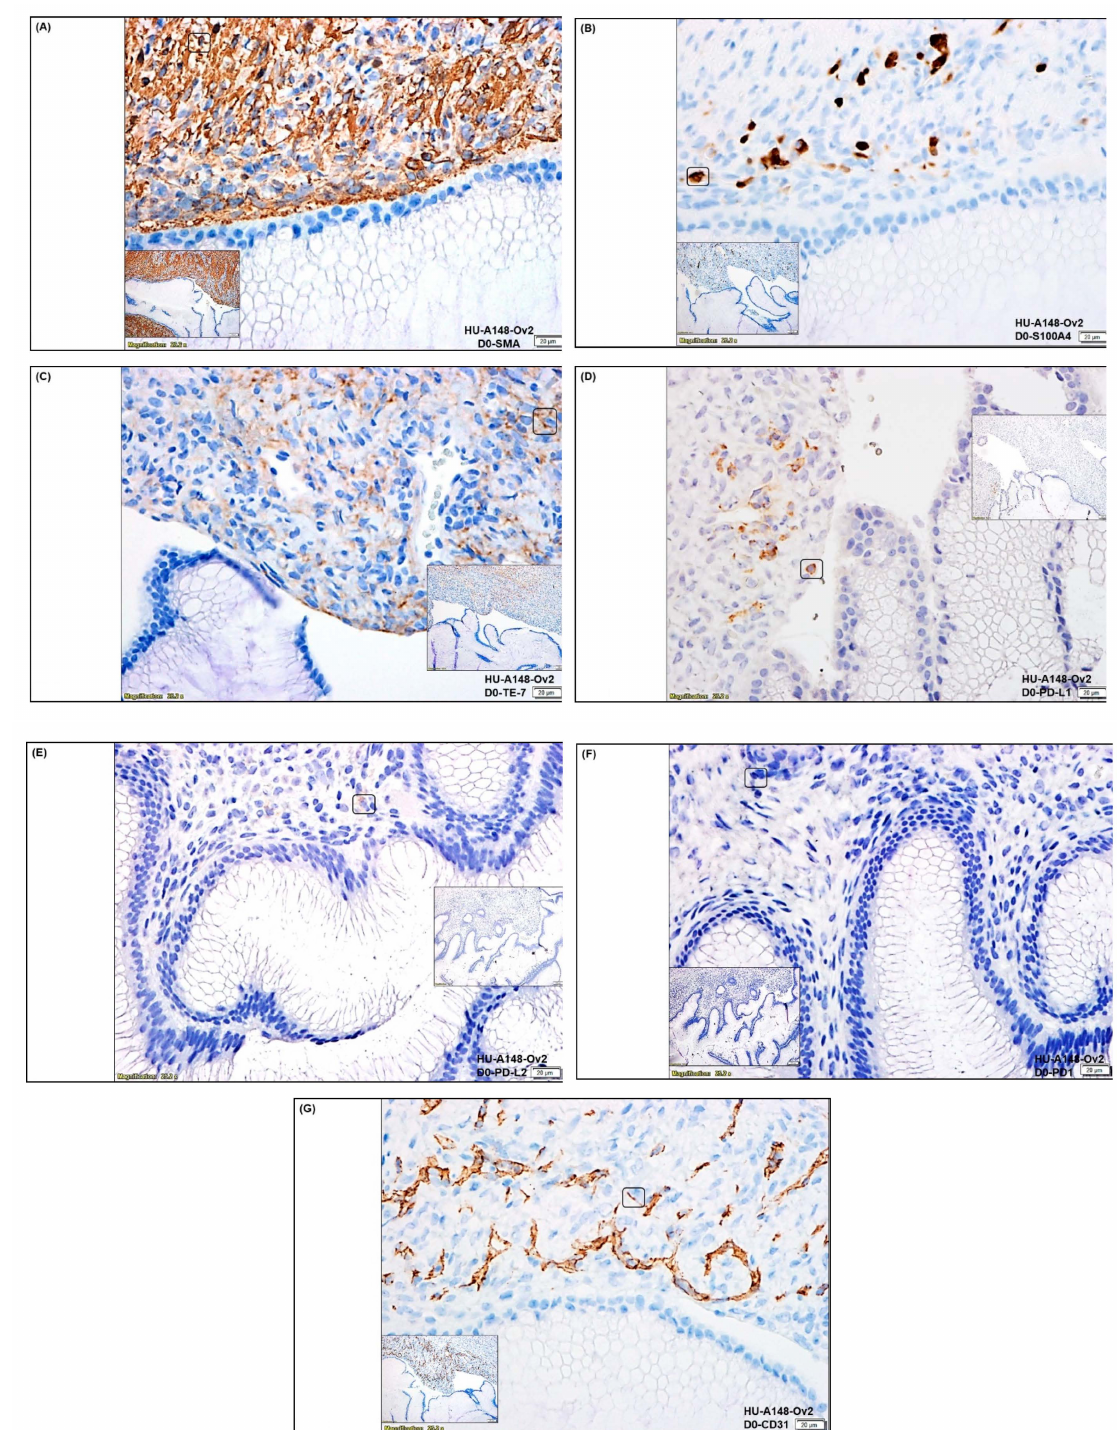
Figure 2. Expression of positive and negative CAF markers, Immune markers, and angiogenic markers in the representative tumor sample of ovarian cancers: We tested the expression of SMA ( A ), S100A4 ( B ), TE-7 ( C ), PD-L1 ( D ), PD-L2 ( E ), PD-1 ( F ), and CD31 ( G ) in tumor samples from patients with ovarian cancers by